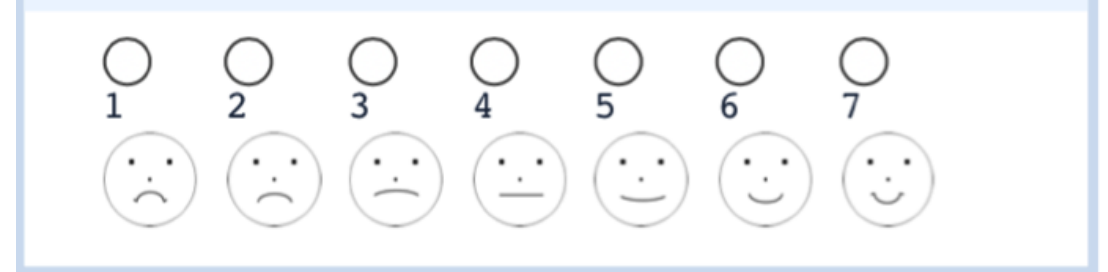
Figure A1. Face images accompanying the Kunin scale for the question assessing overall